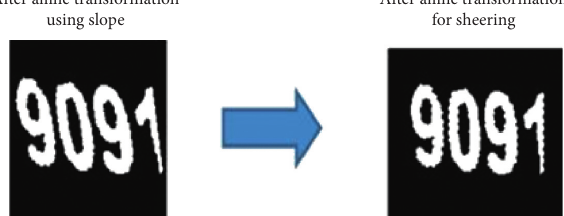
Figure 21: Result after affine sheering.